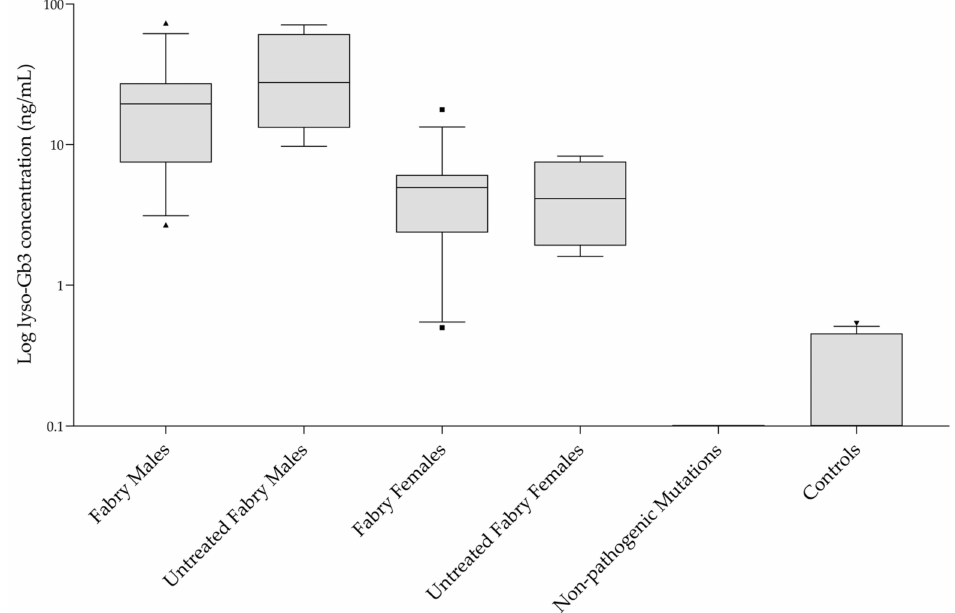
Figure 2. Plasma lyso-Gb3 concentrations for each sample group plotted in log scale. Box plots depict the range between the 25th and 75th percentiles of the data. The horizontal line: median value; capped bars: 10th–90th percentiles; black symbols: outlying values.